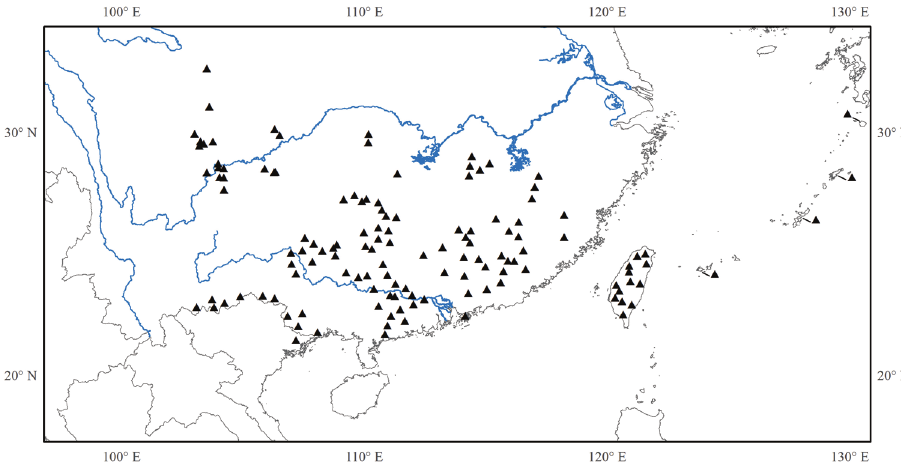
Figure 13. Distribution of Bredia